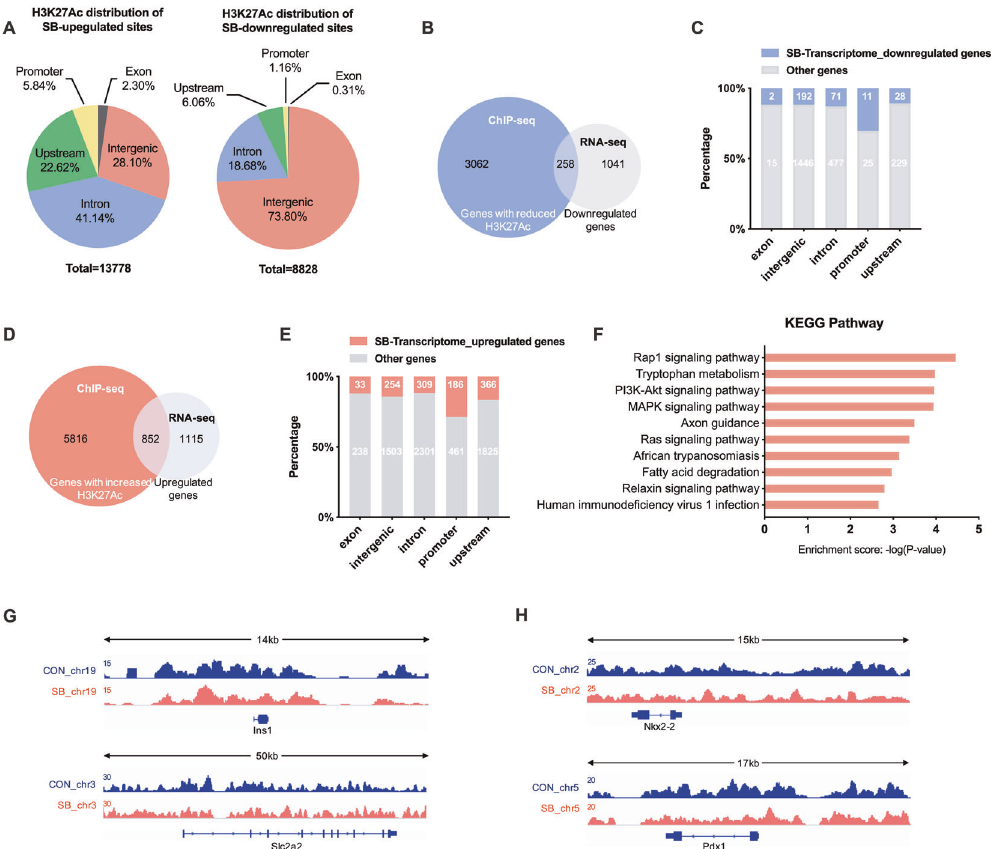
annotated genes with downregulated H3K27Ac occupation and downregulated genes identi fi ed in RNA-seq. C Genomic distribution of both H3K27Ac enriched peaks and corresponding genes downregulated by SB (blue). D Venn diagram of the overlap between annotated genes with upregulated H3K27Ac occupation and upregulated genes identi fi ed in RNA-seq. E Genomic distribution of both H3K27Ac enriched peaks and corresponding genes upregulated by SB (orange). F KEGG pathway analysis on the overlapping upregulated genes by SB at mRNA